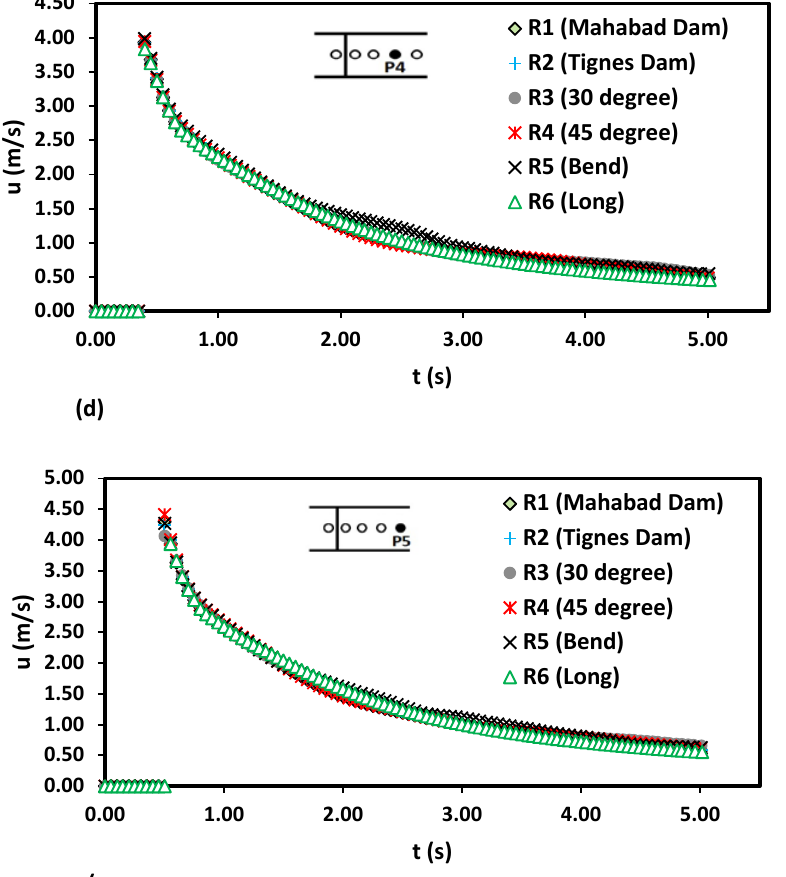
Fig. 11. Velocity component in x direction at five points (P1-P5). Peak velocity component in x direction ( u ). Point